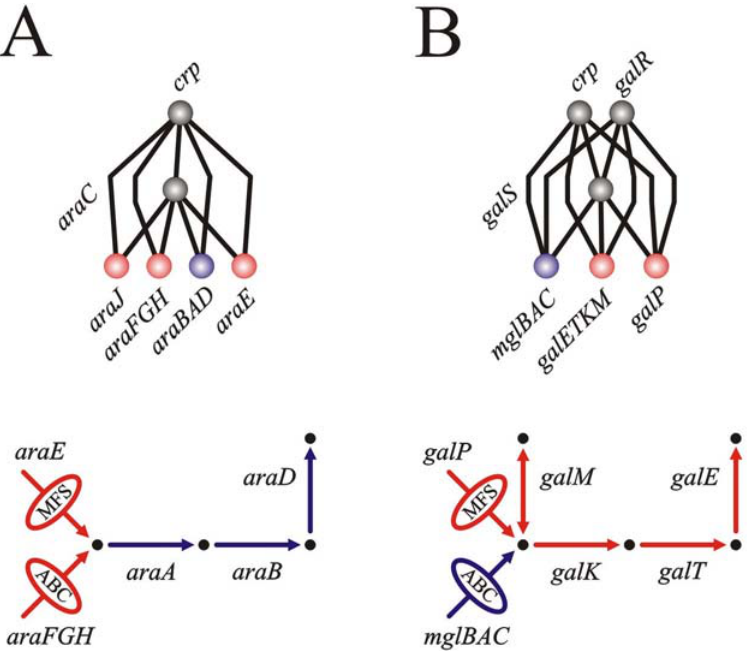
Figure 4. Examples of functional fine-tuning in Z s of hierarchical FFLs: the arabinose (A) and galactose (B) systems. In each case we plotted (top) the incoming/outgoing regulatory interactions associated to the TF sensing the specific sugar and those links involved in FFL assembly, and (bottom) the encoded metabolic pathway, with arrows or ellipses –crossed by arrows– denoting enzymes and transporters, respectively. Each system imports the corresponding metabolite by two different (non-homolog) transporter classes: MFS sugar/proton symporters and ABC transporters. MFS transporters encoded in araE , galP are homologs. ABC transporters in araFGH , mglBAC are also homologs. Note that both examples exhibited maximal FFLness, i.e., F =1. Color code Z -elements: blue, adjacent Z ; red, non-adjacent Z . The same color code applies to the encoded pathway steps. Text S1 for more examples and further discussions.